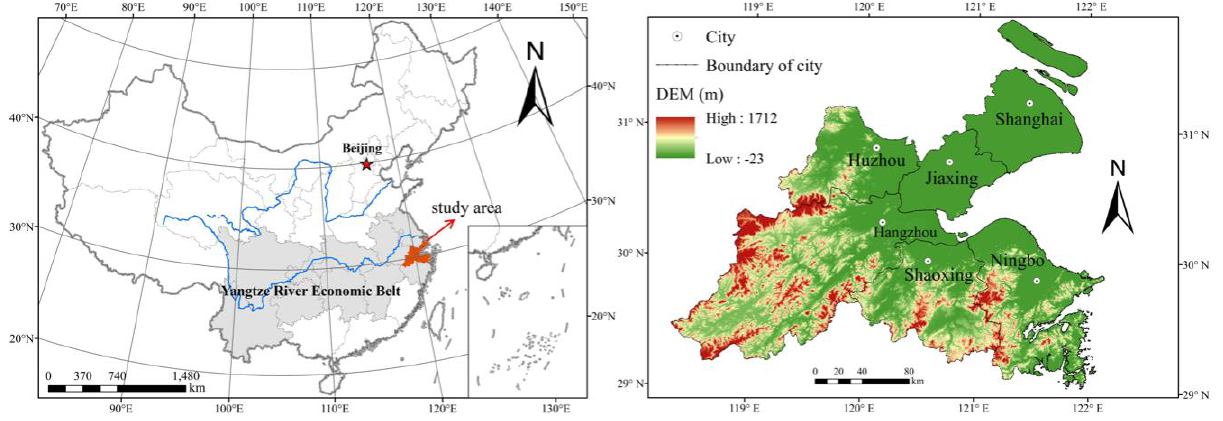
Figure 1. Location of the study area.